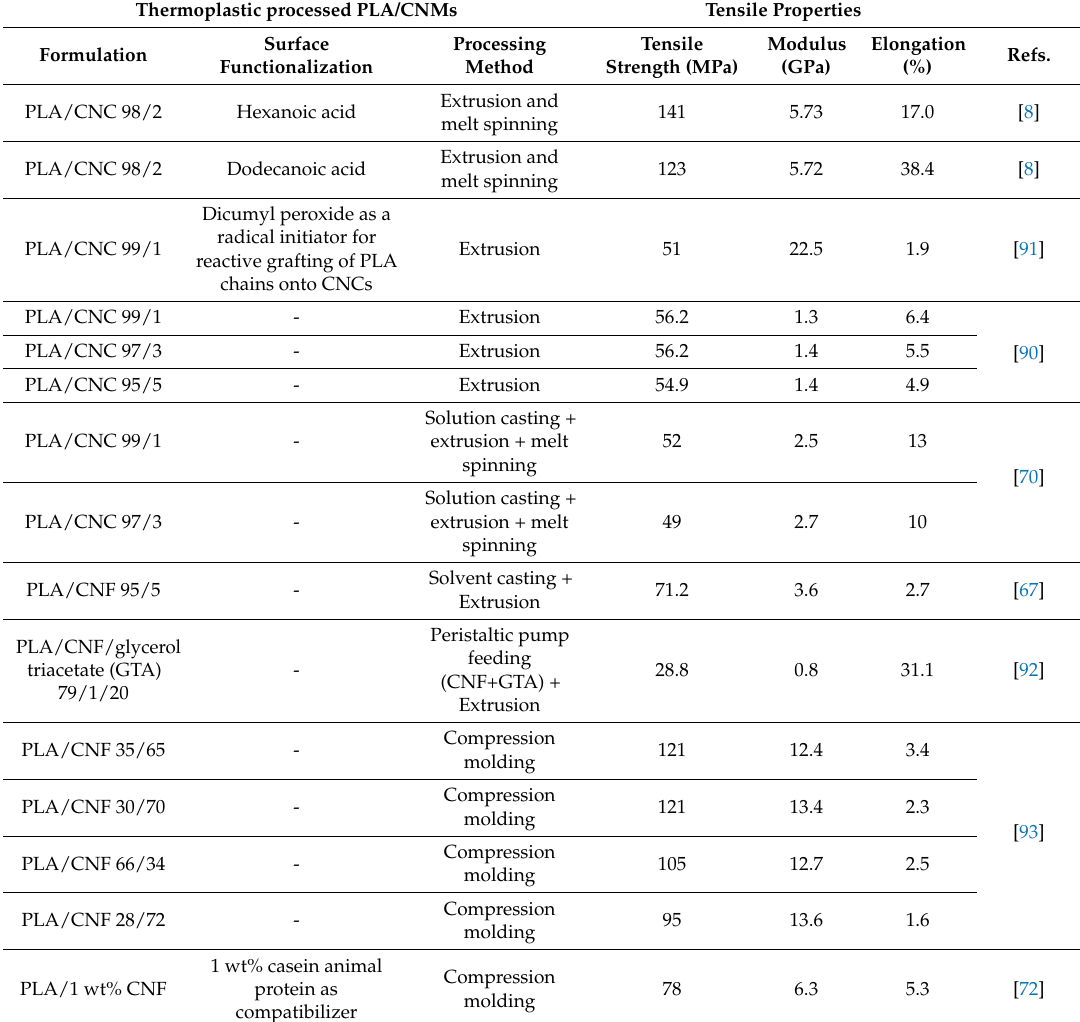
Table 5. Tensile properties of thermoplastic processed PLA/CNMs